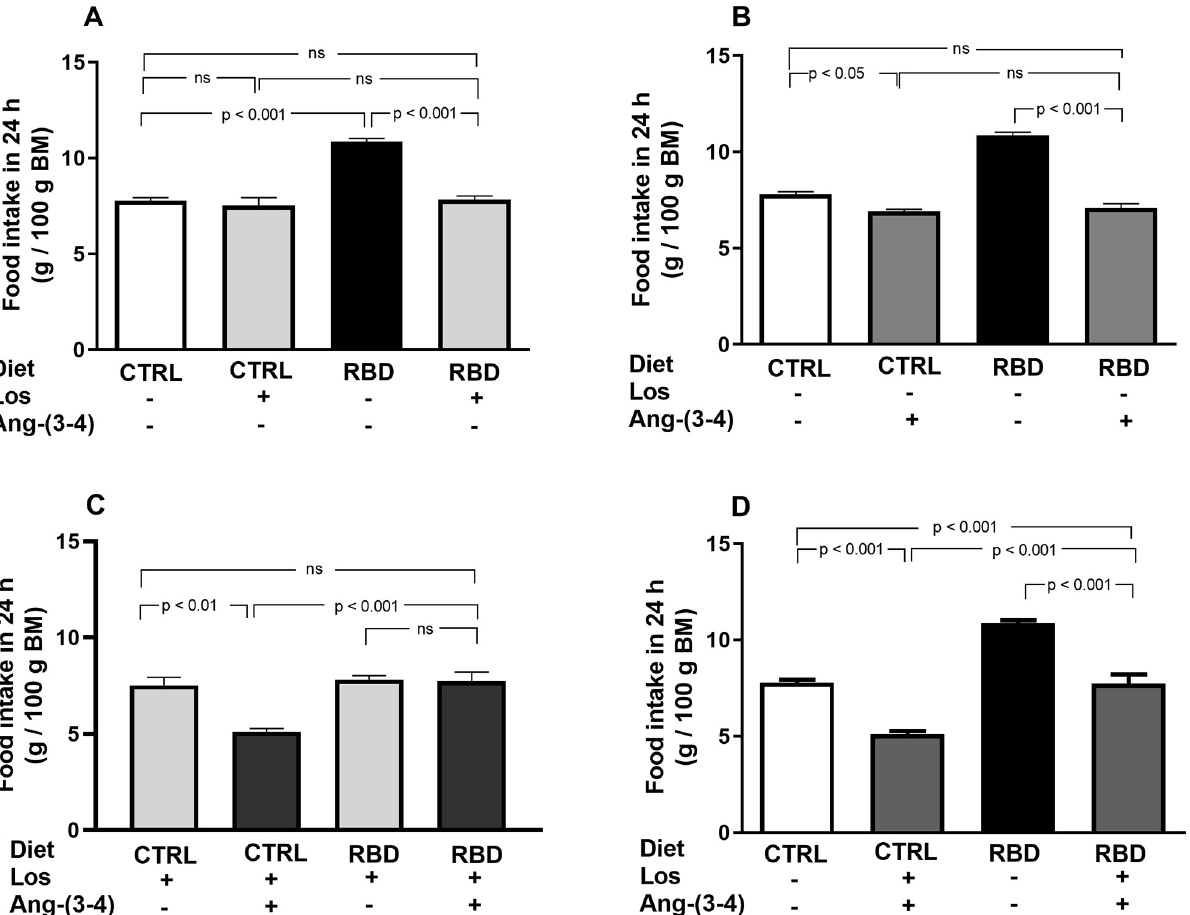
Fig 3. Food intake. (A) Responses to Losartan. Comparison of food intake by CTRL and RBD rats without chronic administration of Losartan, and effects of Losartan administration, as indicated on the abscissa . (B) Responses to Ang-(3–4). Effects of oral administration of a single dose of Ang-(3–4) on food intake by CTRL and RBD rats, as indicated on the abscissa . (C) Responses to Ang-(3–4) in rats previously treated with Losartan. Effects of oral administration of a single dose of Ang-(3–4) on food intake by CTRL and RBD rats previously treated with Losartan, as indicated on the abscissa . (D) Effects of combined Losartan+Ang-(3–4) administration. Comparison of food intake between untreated CTRL and RBD rats vs . CTRL and RBD rats that were chronically given Losartan and a single dose of Ang-(3–4), as indicated on the abscissa . Food intake was measured between 90 and 91 days, except for Ang-(3–4)-treated rats, for which determinations were carried out between 91 and 92 days. Bars are mean ± SEM (data expressed per 100 g BM); n = 5 (CTRL), n = 8 (RBD), n = 5 (CTRL+Los), n = 6 (RBD+Los), n = 5 (CTRL+Ang-(3–4)), n = 8 (RBD+Ang-(3–4)), n = 5 (CTRL+Los+Ang-(3– 4)), n = 6 (RBD+Los+Ang-(3–4)). Differences were assessed using one-way ANOVA followed by Bonferroni’s test for selected pairs. P values are indicated within the